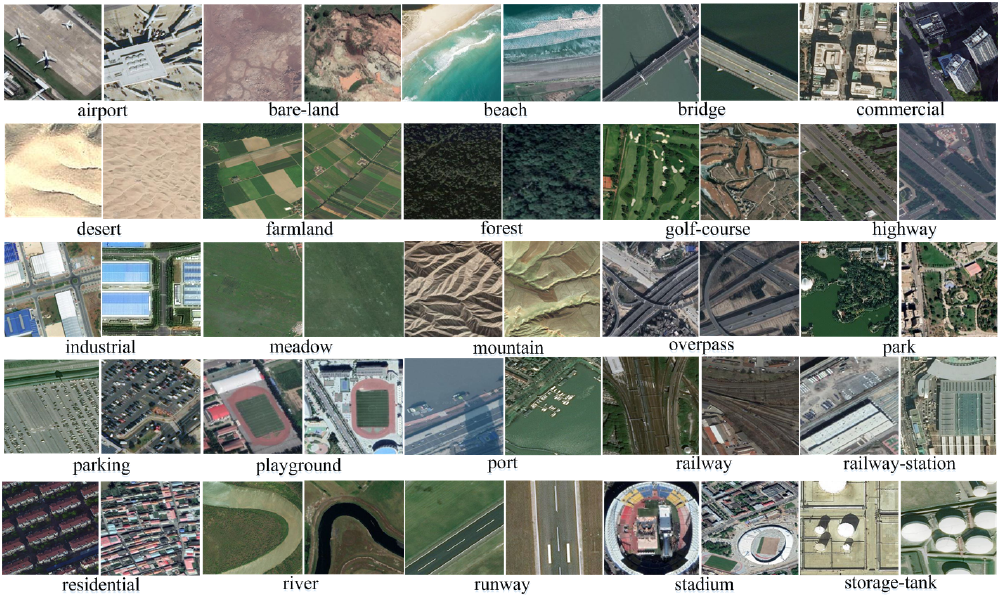
Figure 6. Some example images from CLRS data set: There are 15000 images within 25 classes. For each scene class, there are 600 samples. Two examples of per class are